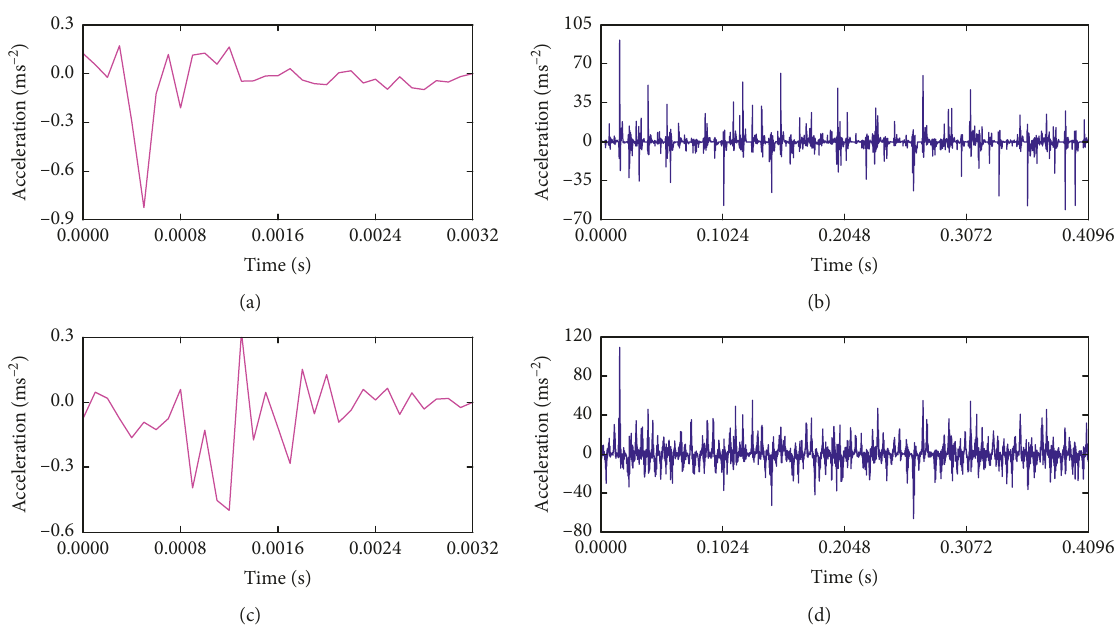
Figure 26: Learned impulse responses and extracted IRSs: (a) the first type of impulse response (IR1); (b) IRS1 of IR1; (c) the second type of impulse response IR2; (d) IRS2 of IR2.